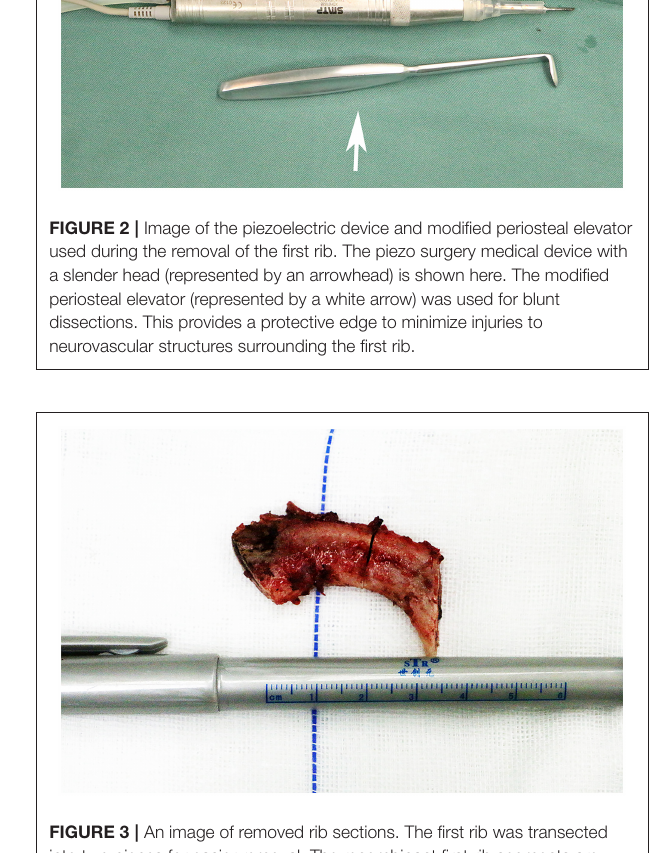
FIGURE 3 | An image of removed rib sections. The first rib was transected into two pieces for easier removal. The recombinant first rib segments are shown